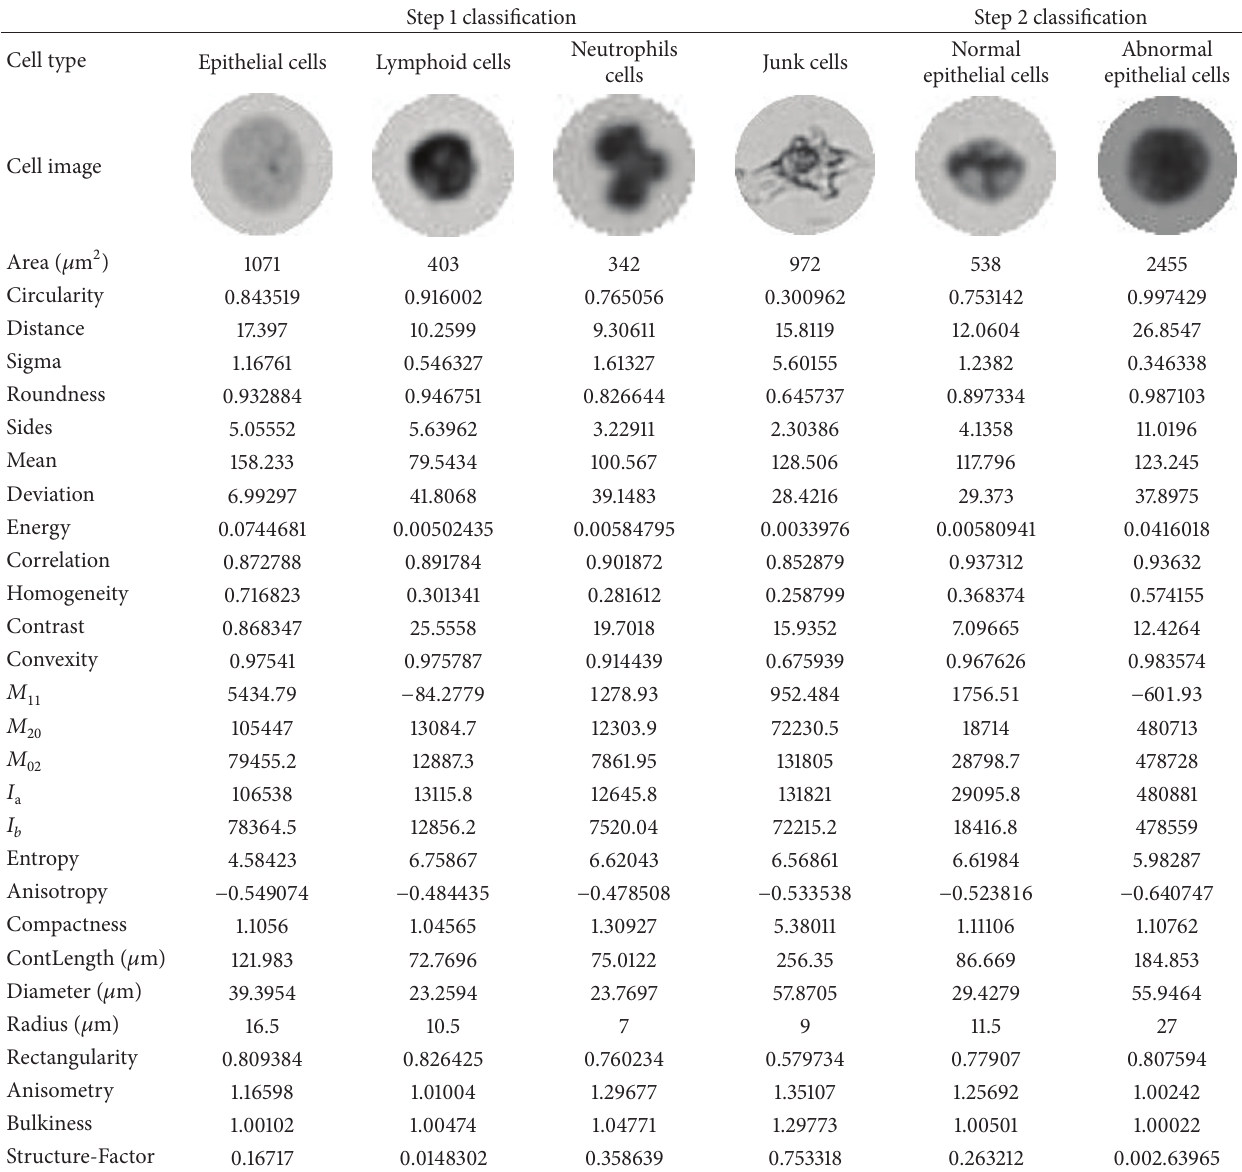
Table 1: Example morphologic and texture features of the nuclei of different type of cells.